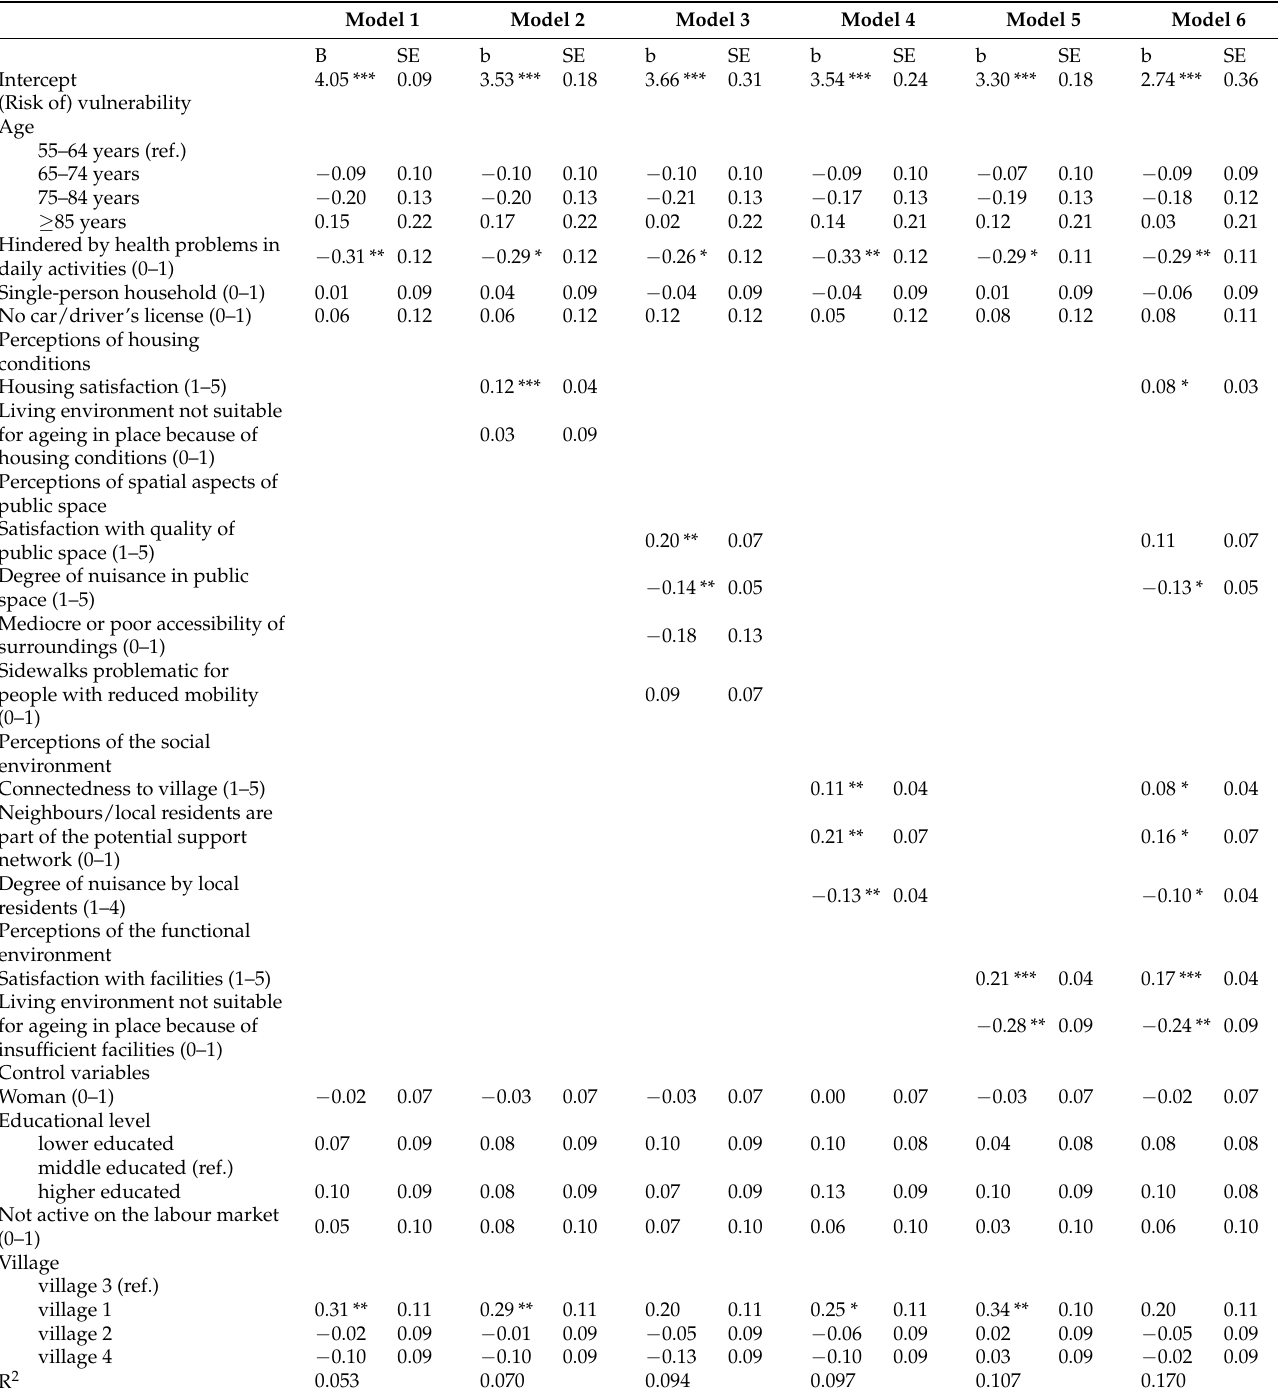
Table 4. Results of a linear regression analysis of perceptions of environmental attributes on the residential satisfaction of people over